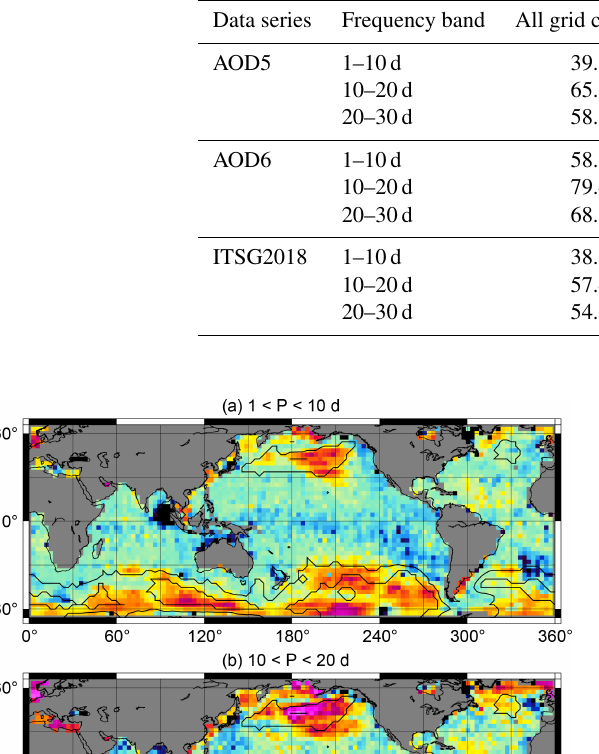
Table 3. Percent of non-coastal ocean area where the altimetric variance is better explained by the given time series than by the CSR swath series. The 2cm RMS bounds are defined in Fig. 3a. Column 5 estimates only over the parts of those regions that are in the Southern Ocean.